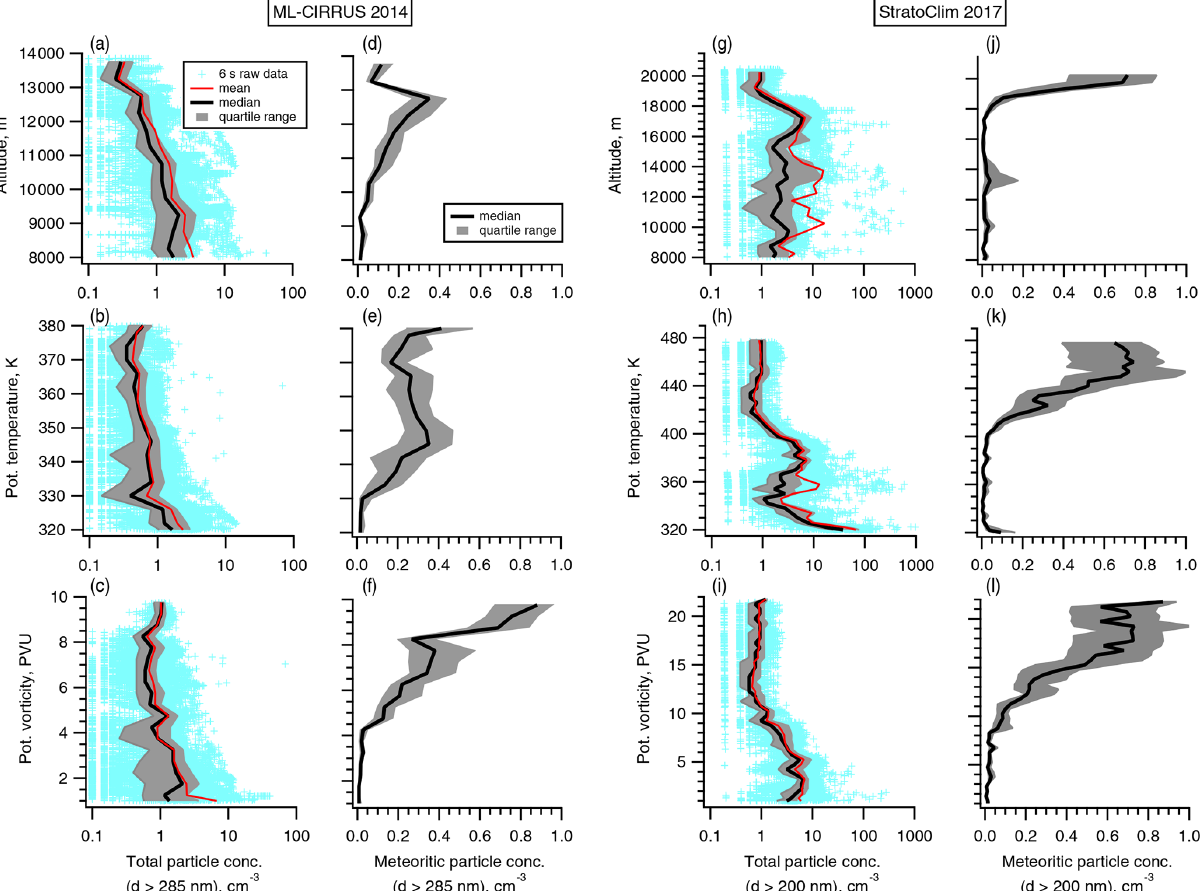
Figure 7. Total particle number concentrations measured during ML-CIRRUS 2014 ( d ve > 285nm, a–c ) and StratoClim 2017 ( d ve > 200nm, g–i ) along with calculated number concentrations of particles containing meteoric material (ML-CIRRUS 2014: d–f ; StratoClim 2017: j–l ). Data are shown for the upper troposphere and lower stratosphere (altitude > 8km, potential temperature > 320K, PV > 1PVU). Light-blue markers: 6s raw data; red line: mean; black line: median; grey area: quartiles (25% and